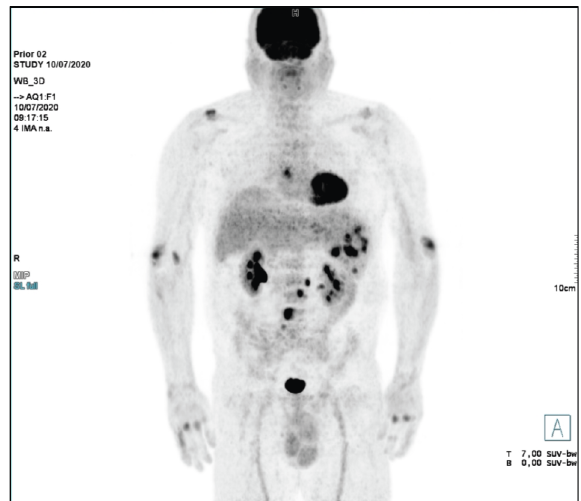
Figure 3:18F-FDG PET/CTperformed 15 months after MTX withdrawal with an increased hypermetabolic activity in the spleen and a new hypermetabolic lesion involving the L4 vertebral body, consistent with progressive